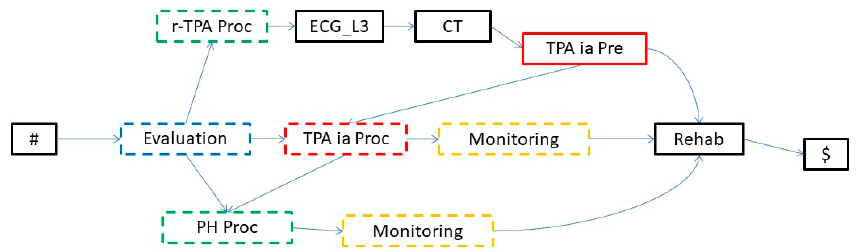
Figure 10. Process model abstracted at level 2 through the solution in Figure 11b.